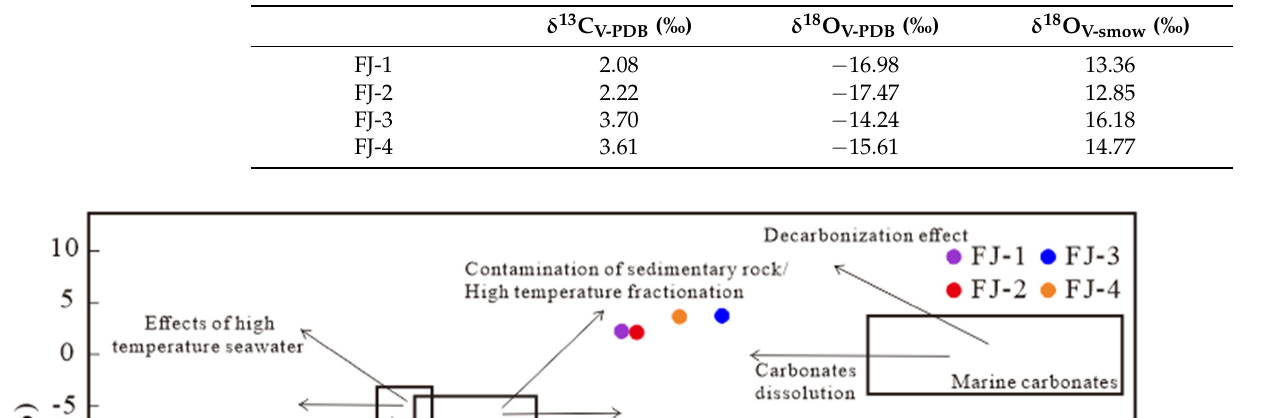
Table 2. C-O isotopic compositions (‰) of FJ-1, FJ-2, FJ-3, and FJ-4.